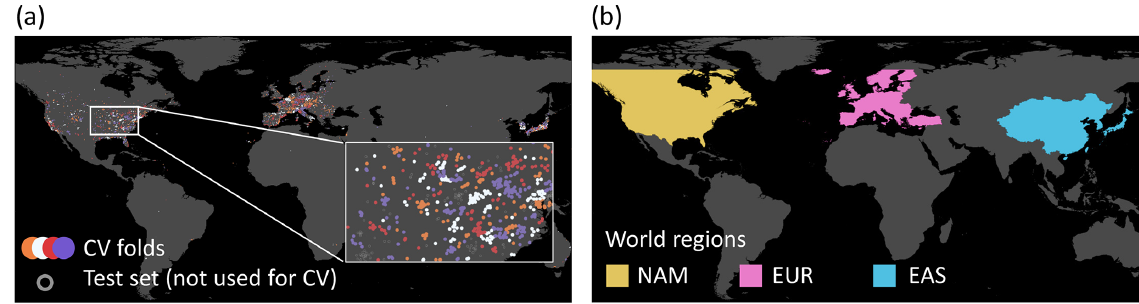
Figure 3. Data splits for the spatial cross validation. (a) Station clusters are randomly assigned to four cross-validation (CV) folds. (b) The data are divided by the world regions North America (NAM), Europe (EUR), and East Asia